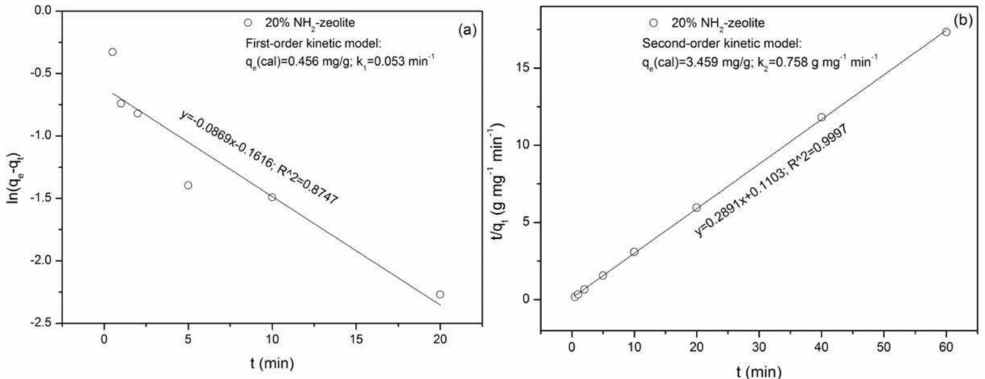
Figure 8. Plots of pseudo-first-order ( a ) and pseudo-second-order kinetic ( b ) models for adsorption of chromate ions onto 20% amino functionalized zeolite